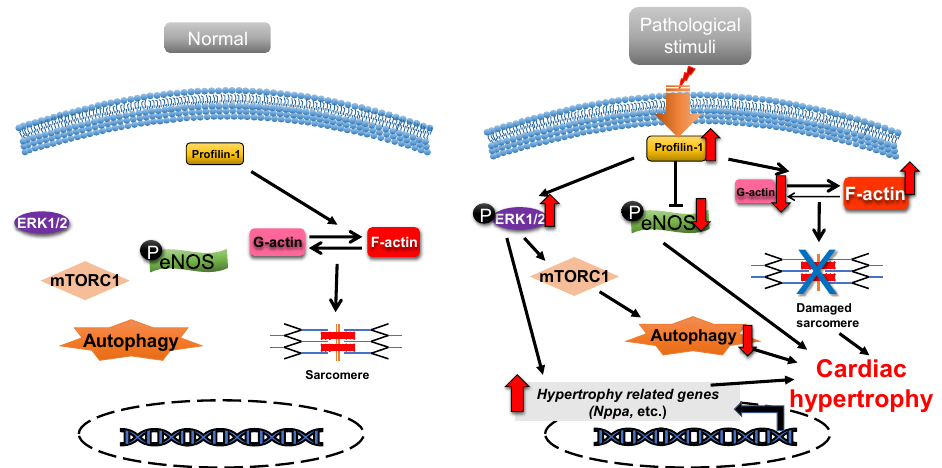
Figure 2. Profilin-1 mediates cardiac hypertrophy. In normal cardiomyocytes, profilin-1 is at a basal level and the fetal genes are not activated. Pathological stimuli increase the protein level of profilin-1, which results in ERK1/2 activation, F-actin accumulation and eNOS inhibition. This results in the reactivation of hypertrophy-related genes, inhibition of autophagy and damage to sarcomere structure and, ultimately, the development of cardiac hypertrophy.